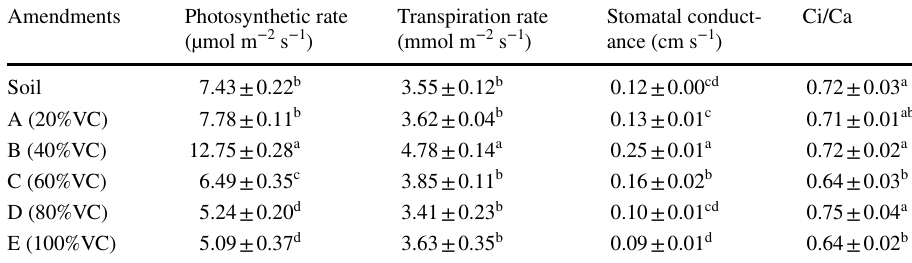
Table 2 Variation in selected physiological characteristics of A. esculentus plants grown in different amendment rates of MSW